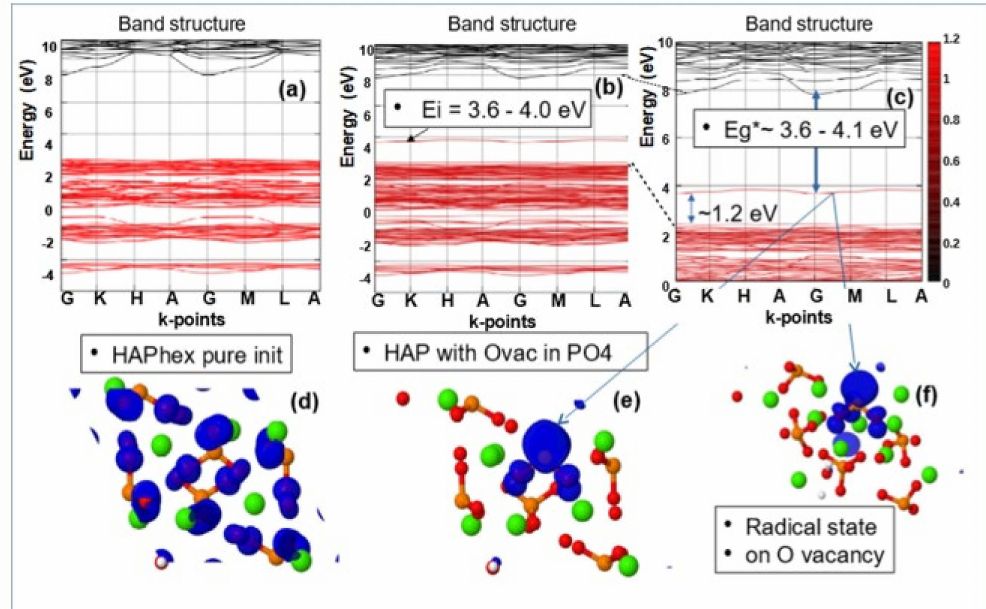
Figure 9. Band structure and partial charge density distribution for O-vacancy from PO 4 group in hexagonal HAP (for one unit cell model): ( a , d ) band structure and partial charge density (top view) of initial pure HAP; ( b , e ) band structure and partial charge density (top view) for HAP with O-vacancy from PO4 (local energy level Ei ~3.6–4.0 eV is the middle of the Eg band and with ∆ E = Ei − Ev ~1.1–1.3 eV); ( c ) band structure distribution along k-points with local energy level leaded to optical Eg*~3.6–4.1 eV in comparison with total Eg ~5.34 eV; ( f) partial charge density for electrons with their eigenvalues around the energy level Ei of the O-vacancy of PO 4 group in HAP (side view of the unit